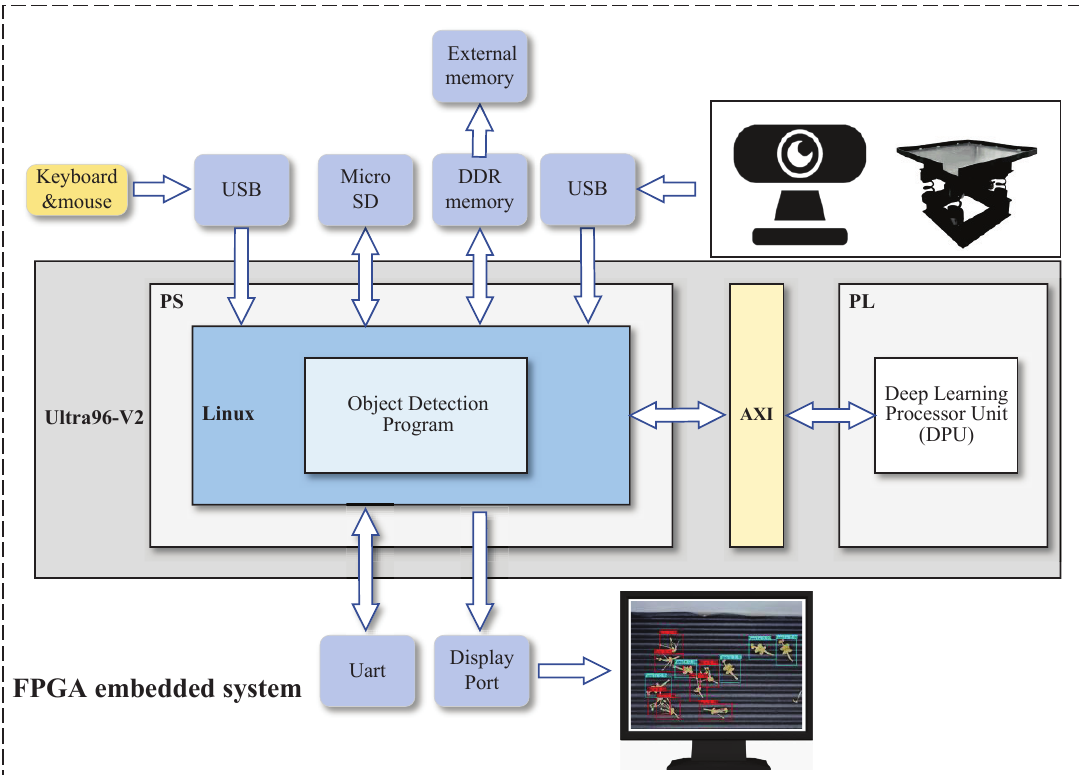
Figure 7. Workflow of male and female litchi flower detection